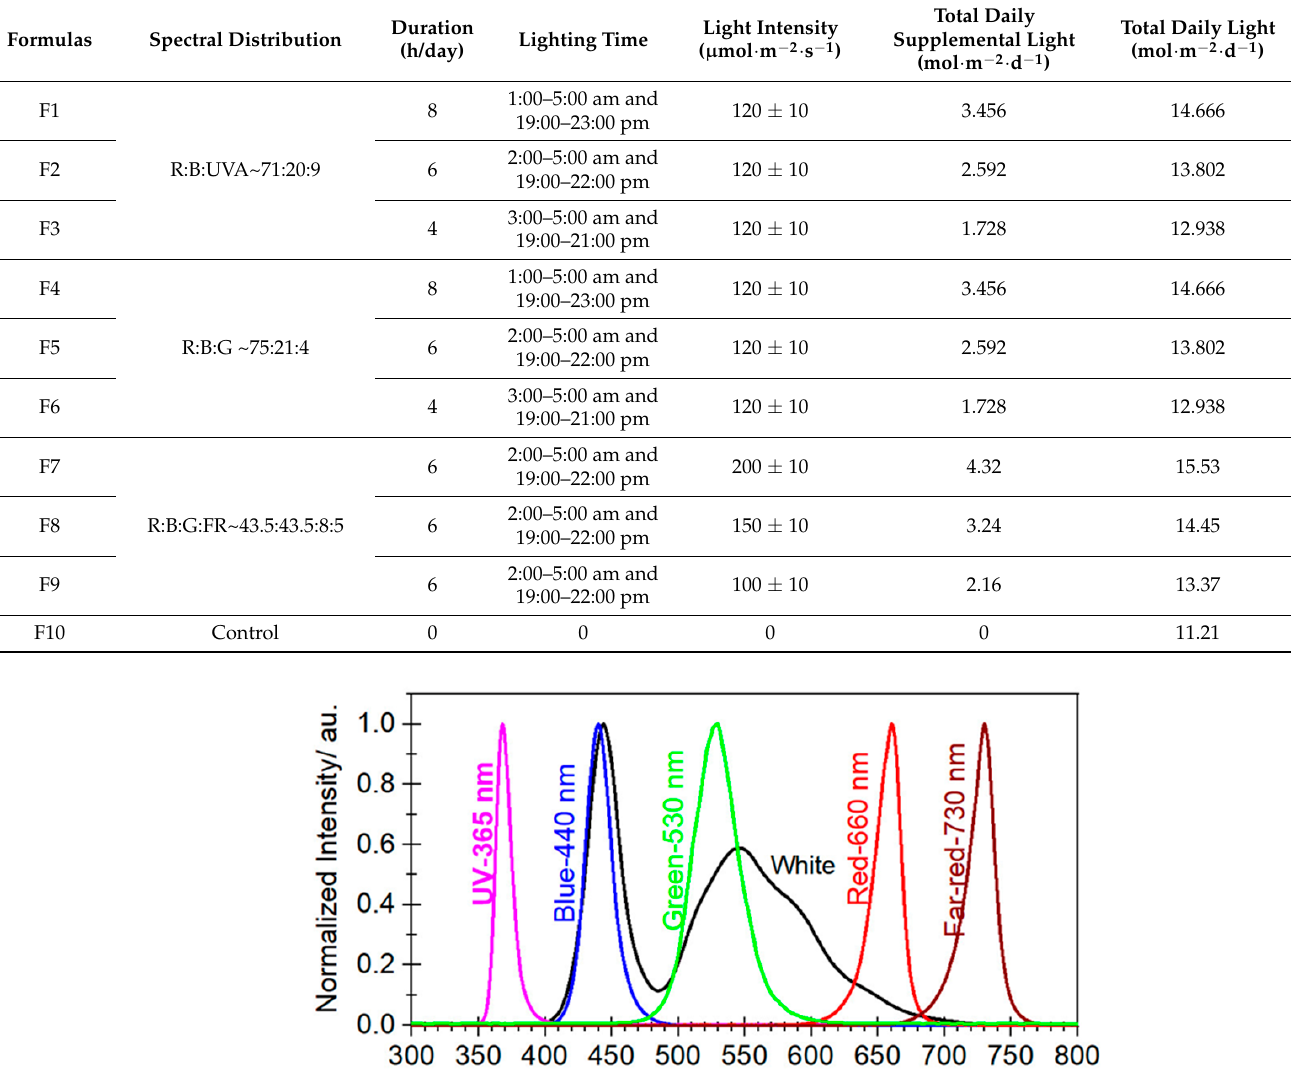
Table 5. Supplemental light conditions in cultivation of O. basilicum .